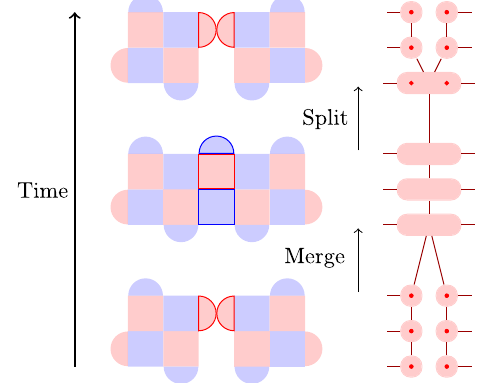
FIG. 22. A slice of the matching graph for lattice surgery, which can be interpreted as switching between different gauge fixes of a subsystem code. Left: the three stages of lattice surgery are shown for a distance-3 rotated surface code. Red (blue) squares and semicircles denote X ( Z ) stabilizers, with data qubits at their corners. Right: a slice of the matching graph for the X stabilizers at the boundaries of the two codes where the merge takes place (denoted with red borders in the left diagram). Stabilizer measurements are repeated three times for each stage of lattice surgery, with the generalized difference syndrome used to connect the stabilizer with its gauge